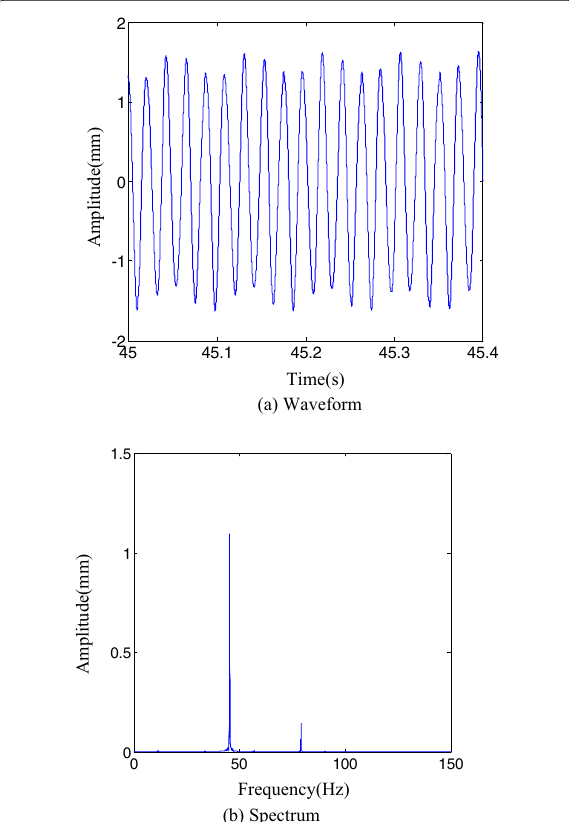
Figure 18 Waveform and spectrum in the x -direction when the disc and the shaft have a large difference in rotation speed